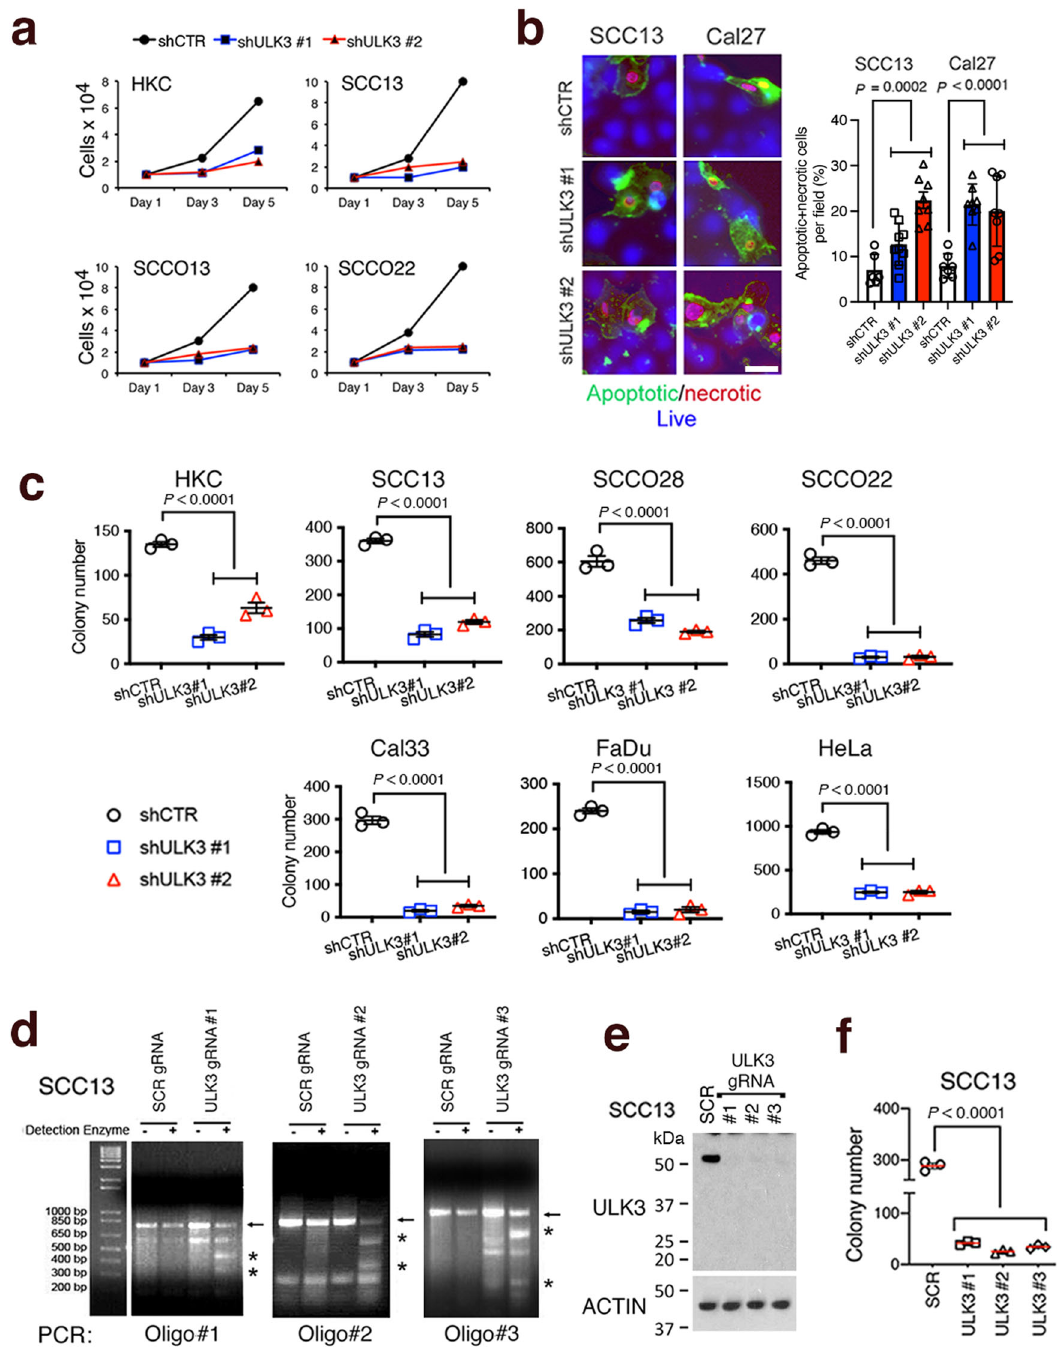
Fig.2|TheproliferativepotentialofHKCsandSCCcellsissuppressedbyULK3 downmodulation.a Cellgrowthondays3and5ofHKC(strain#TP26)andofthree SCC cell lines infected with two ULK3 silencing lentiviruses (shULK3 #1, #2) versus empty control vector (shCTR) plated in triplicate at low-density. Representative experimentoftwoindependentbiologicalreplicates.Theef fi cientdownregulation of ULK3 in HKCs and SCC cells is in Supplementary Fig. 2a, b. b Live fl uorescence images of SCC13 and Cal27 cells infected with two ULK3 silencing lentiviruses, or control virus, and stained for early- (phosphatidylserine-FITC, green), late- apop- tosis (7-aminoactinomycin D, magenta) and for all viable cells (CytoCalcein, violet- blue). Quanti fi cation, in duplicate cultures, SCC13 n ( fi elds/shCTR)=6, n ( fi elds/ shULK3)=25; Cal27 n ( fi elds/shCTR)=7, n ( fi elds/shULK3)=24, n (cells/ fi eld)>90, mean±SEM, P <0.001 or P <0.0001 one-way ANOVA. Scale bar 10 µ m. c Colony formation of HKCs (strain # TP26), fi ve SCC cell lines and HeLa cells infected with two ULK3 silencinglentiviruses,oracontrolvirus,andplatedatlimitedcelldensity for one week. Crystal violet stained dishes were quanti fi ed using ImageJ.